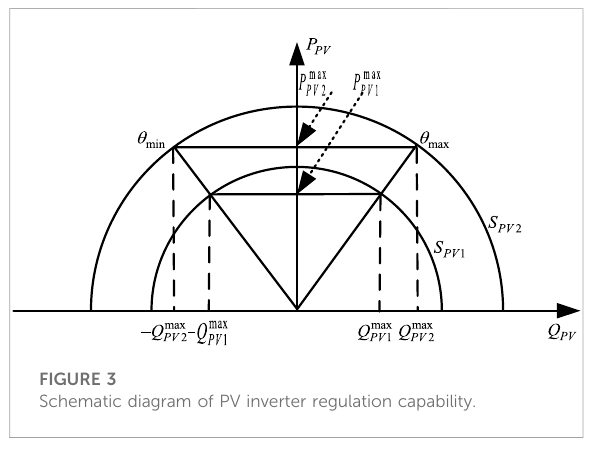
FIGURE 3 Schematic diagram of PV inverter regulation